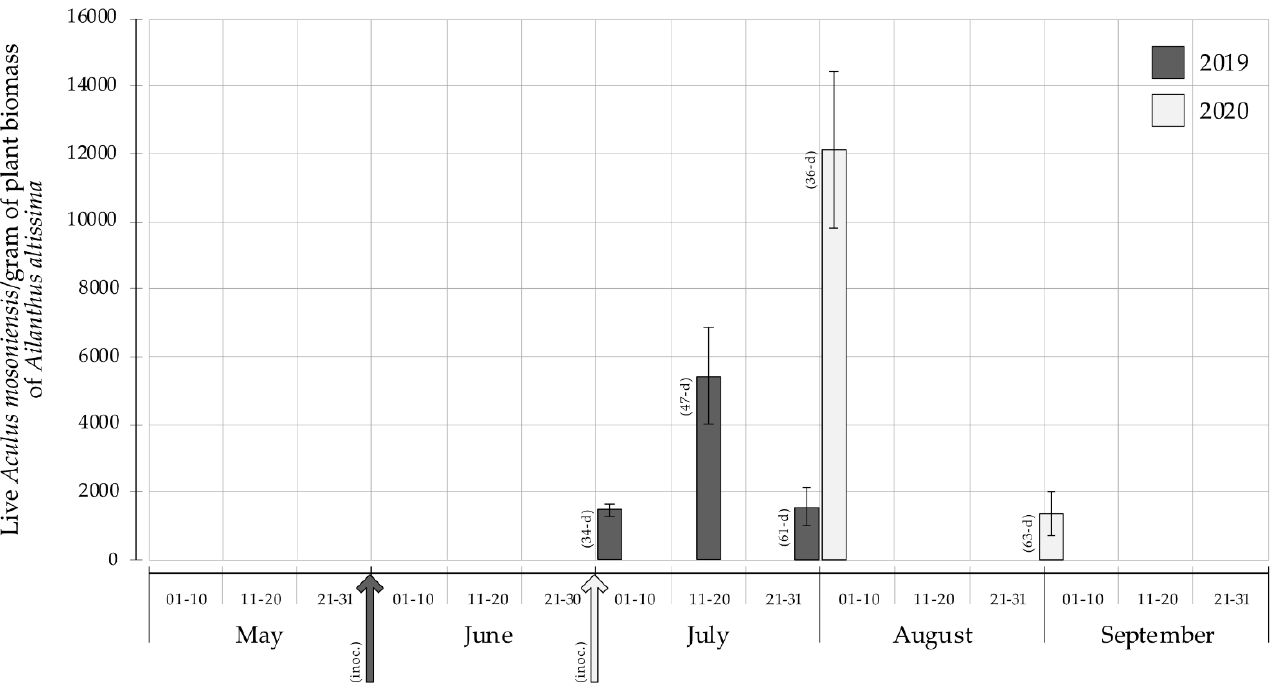
Figure 5. Number of live Aculus mosoniensis per gram of plant biomass collected from Ailanthus altissima (mean ± SE) through the season in field experiments performed in 2019 and 2020, respectively. The arrows represent the inoculation day (inoc.), whereas days after inoculation are indicated in brackets flanking the bars (34, 47, and 61 days in 2019; and 36 and 63 days in 2020).